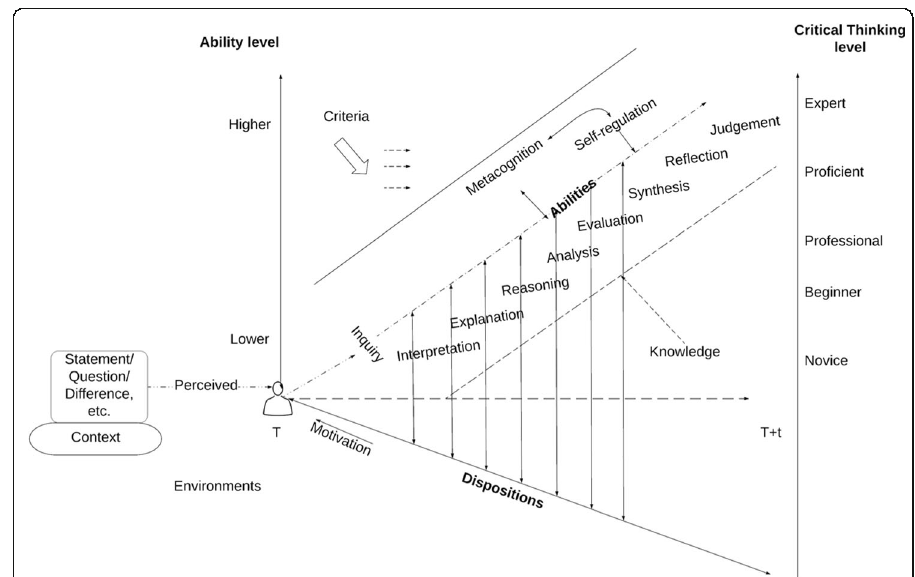
Fig. 1 A framework of critical